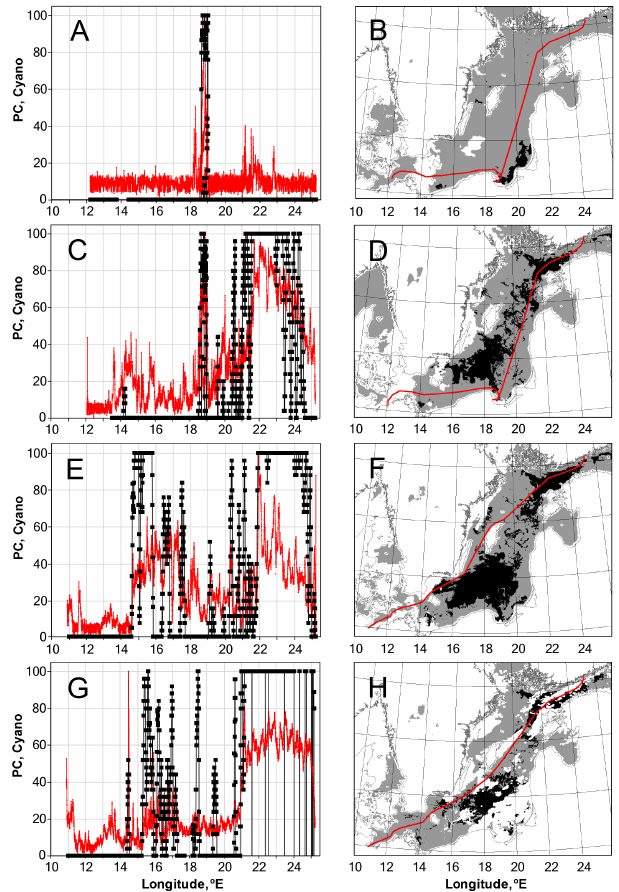
Figure 10. Monthly mean FCA in June, July and August for the Baltic Sea based on ocean color satellite data in